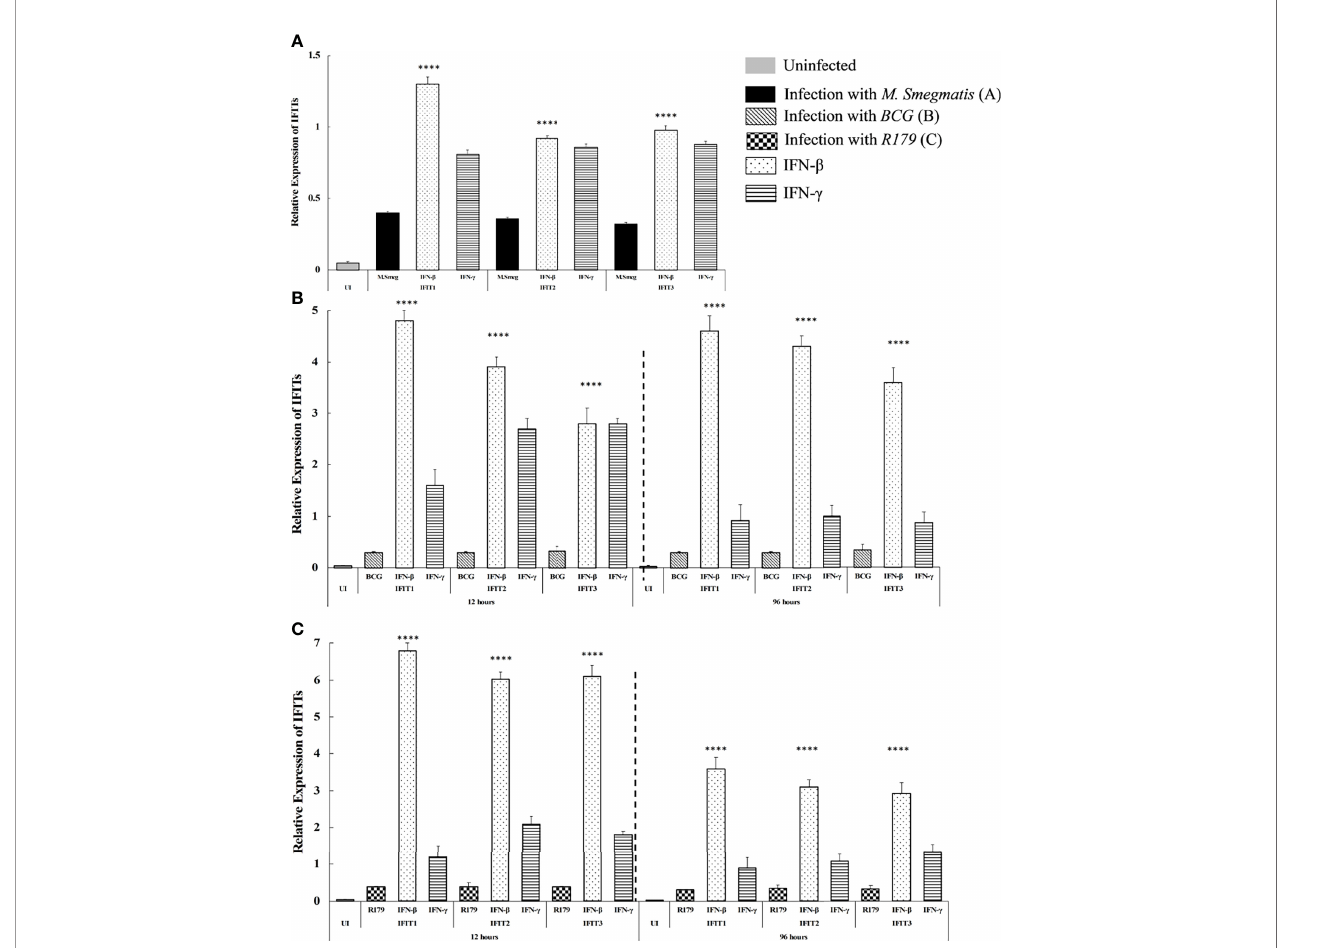
FIGURE 4 | qRT-PCR determining the effect induced from treatment of IFN- b and IFN- g on the expression of IFITs in hMDMs infected with (A) M. smegmatis at 12 hours, (B) M. bovis BCG at -12 hours and -96 hours, and (C) M. tb R179 at -12hours and -96 hours post infection. In hMDMs after infection with all three species ( M smegmatis, M bovis BCG and M.tb R179), we found expression of IFIT1, IFIT2 and IFIT3 found to be higher in hMDMs stimulated with IFN- b compared to untreated and IFN- g treated hMDMs. ****p<0.0001 (higher in IFN- b stimulated